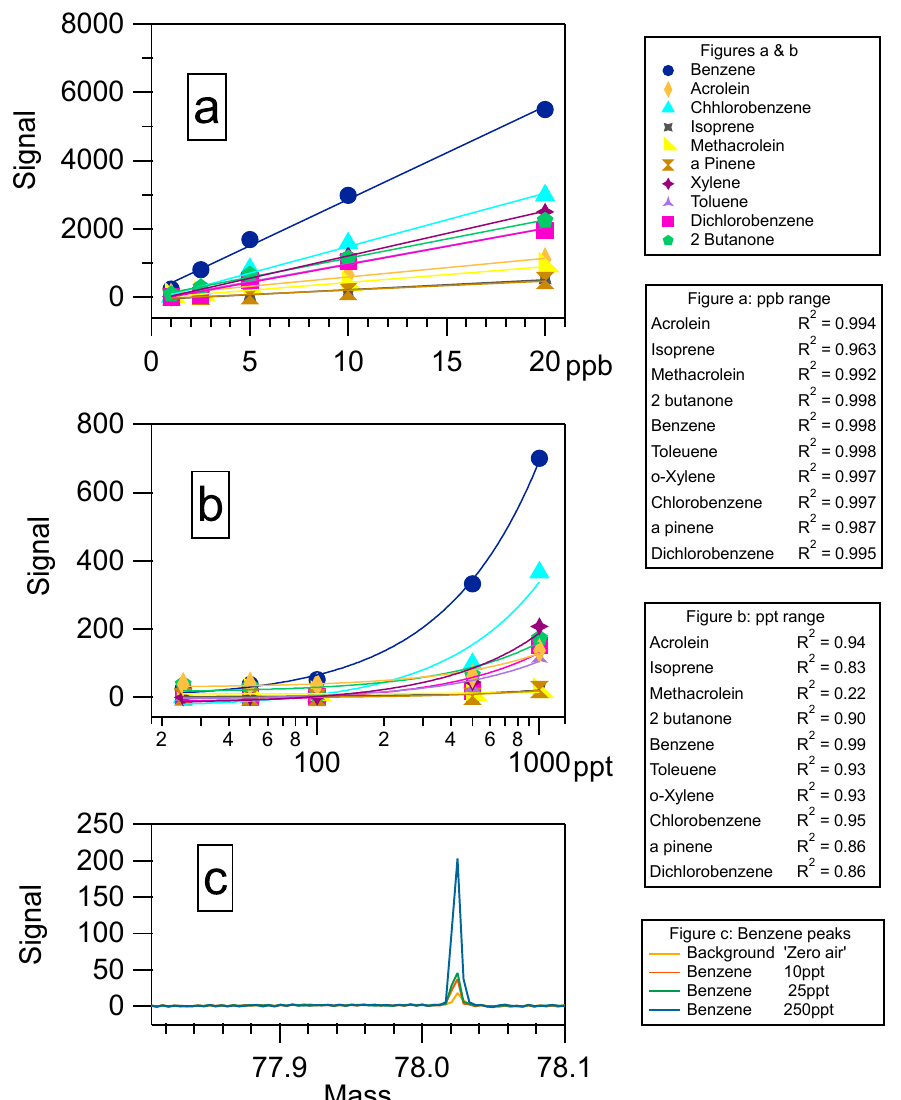
Figure 4. Calibration curves at: ( a ) ppb and ( b ) ppt levels, and ( c ) mass spectrum of the benzene peaks at low-ppt-level concentrations.